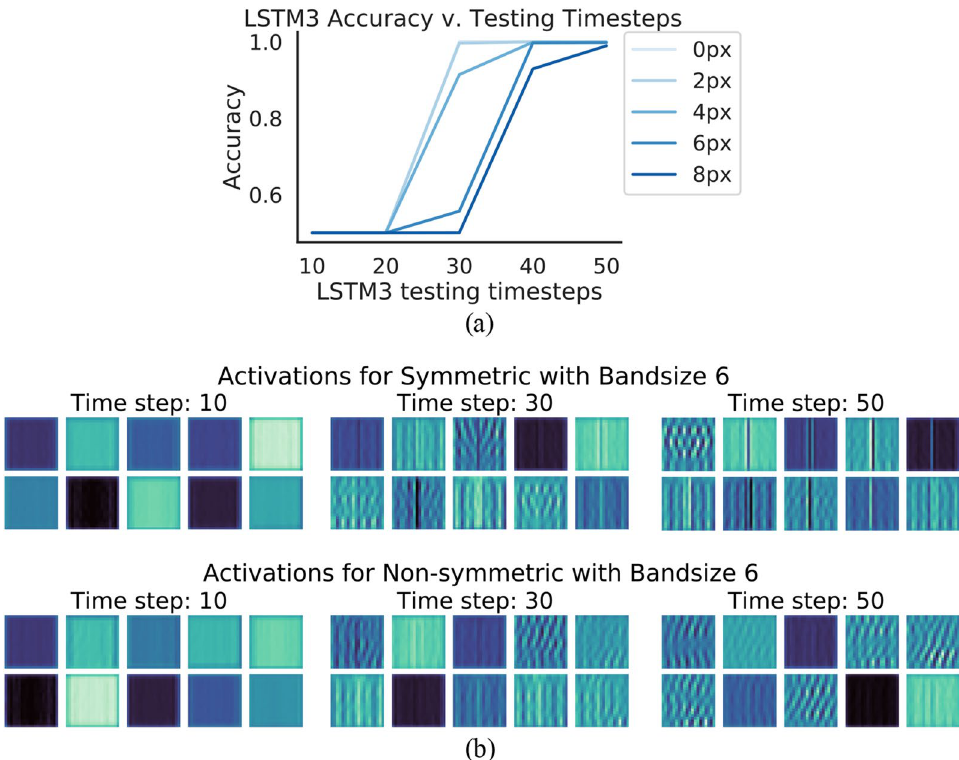
Figure 7. Analysis of LSTM3 representations. ( a ) Plot of the accuracies achieved by the LSTM3 with restricted numbers of time steps for different categories of Stripe datasets (indicated with the number of pixels between stripes). ( b ) Visualization of 10 representative activation maps from the last LSTM3 cell at various timesteps, for symmetric and non-symmetric images. Each pixel represents the degree of activation of a neuron in the activation map (darker colors mean values closer to 0 while lighter colors mean larger values). Note that as the timesteps progress, the center axis becomes highlighted for symmetric